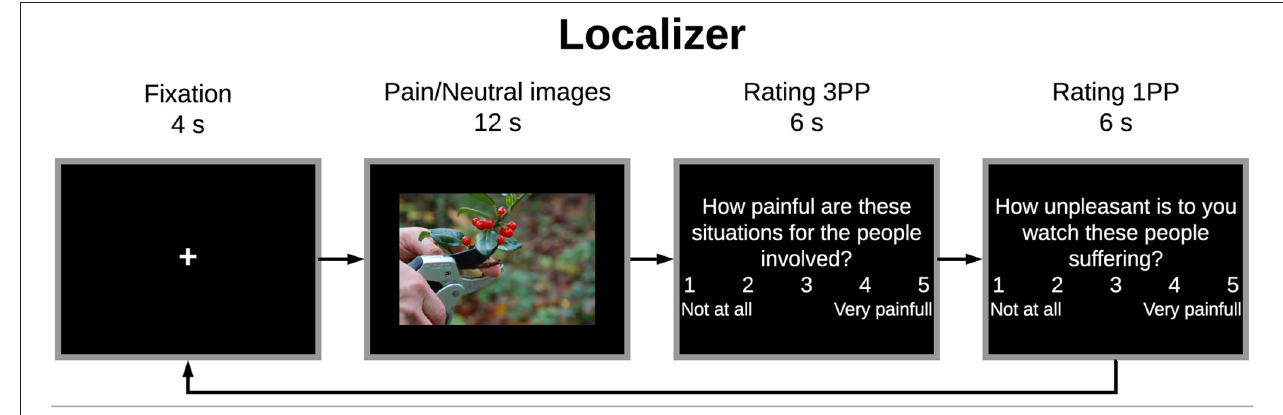
FIGURE 3 | Protocol scheme for each trial of the localizer run: trial started with a fixation cross (4s) followed by a set of 7 painful or neutral images (12s)—alternated between trials, ending with two behavioral ratings regarding empathy for the pain of the other (rating “third-person” perspective − 3PP) and personal distress (rating “first-person” perspective − 1PP) (6s per